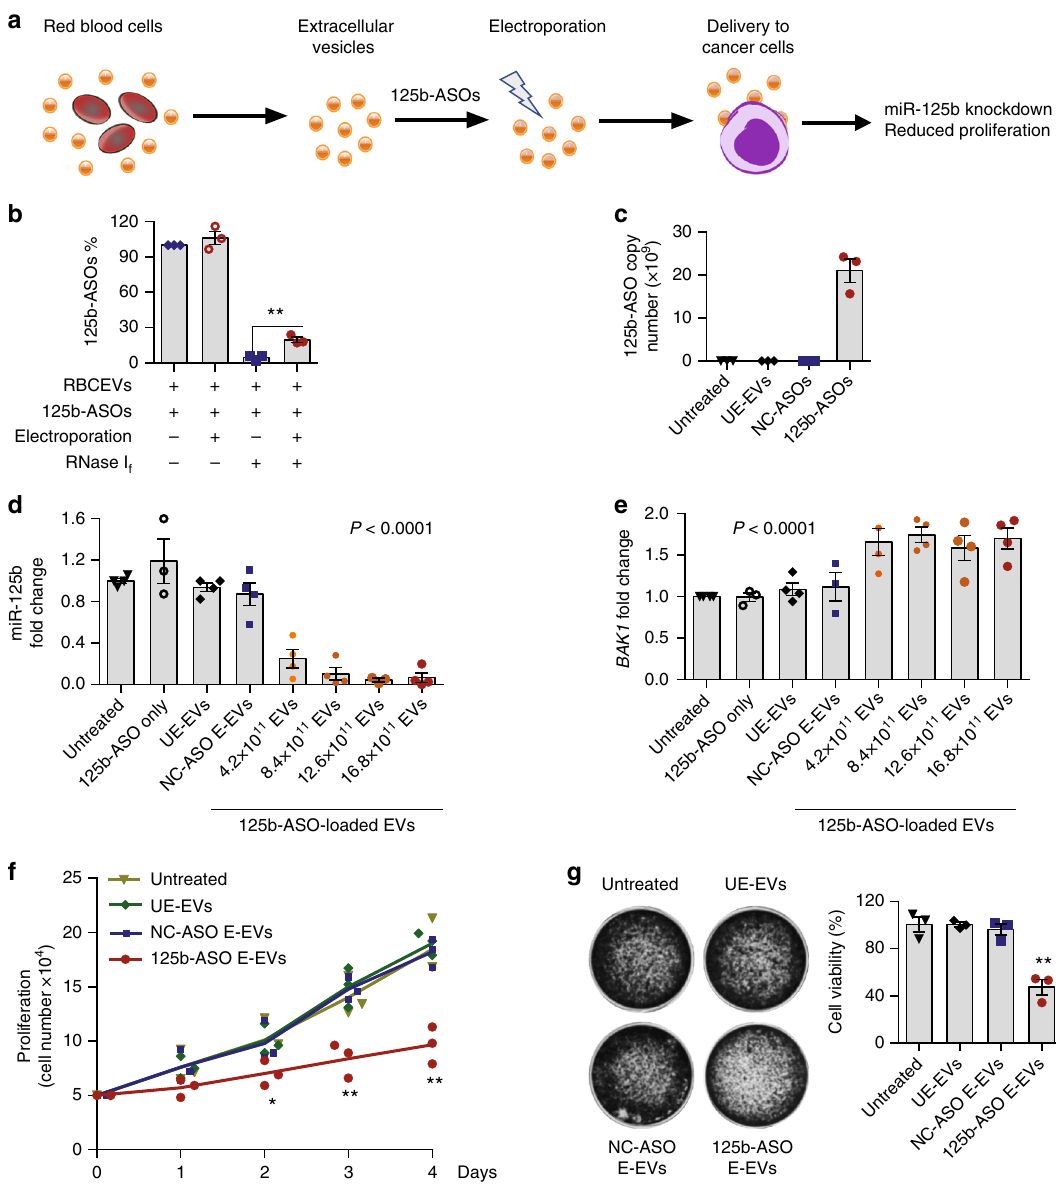
Fig. 3 RBCEVs deliver ASOs to leukemia and breast cancer cells for miR-125b inhibition. a Experimental scheme of ASOs delivery to cancer cells using RBCEVs. b Percentage of anti-miR-125b ASOs (125b-ASOs) associated with 6.2 × 10 11 unelectroporated or 125b-ASO-electroporated RBCEVs after a treatment with RNase I f for 30 min. c Copy number of 125b-ASO in MOLM13 cells treated with 12.4 × 10 11 RBCEVs unelectroporated (UE-EVs) or RBCEVs electroporated with NC-ASOs or with 125b-ASOs for 72 h. d Expression fold change of miR-125b in MOLM13 cells that were incubated with 125b-ASOs alone, 16.8 × 10 11 unelectroporated RBCEVs (UE-EVs), 16.8 × 10 11 NC-ASOs-loaded RBCEVs, or 4.2 to 16.8 × 10 11 125b-ASOs loaded RBCEVs. miR-125b expression was determined using Taqman qRT-PCR normalized to U6b RNA and presented as average fold change relative to the untreated control. e Expression fold change of BAK1 in MOLM13 cells treated as in d , determined using SYBR Green qRT-PCR, normalized to GAPDH and presented as average fold change relative to the untreated control. f Proliferation of MOLM13 cells treated with 12.4 × 10 11 unelectroporated or NC/125b-ASO-electroporated EVs, determined using cell counts. g Viability of breast cancer CA1a cells (%) treated as in f , determined by crystal violet staining. In all panels, the experiments were repeated three or four times with 3 or 4 cell passages. Bar graphs present mean ± SEM. P values were calculated using one-way ANOVA test ( d , e ) or student ’ s one-tail t -test relative to the untreated controls ( b , f , g ) * P < 0.05, ** P <